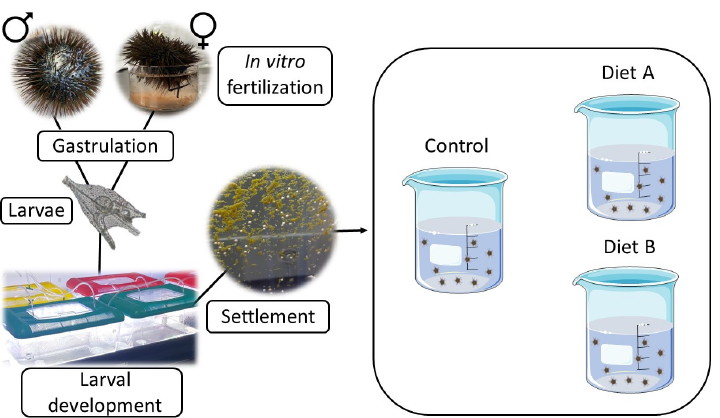
Figure 1. Experimental scheme of the feeding trial with control diet and diets A and B, starting from the in vitro fertilization.